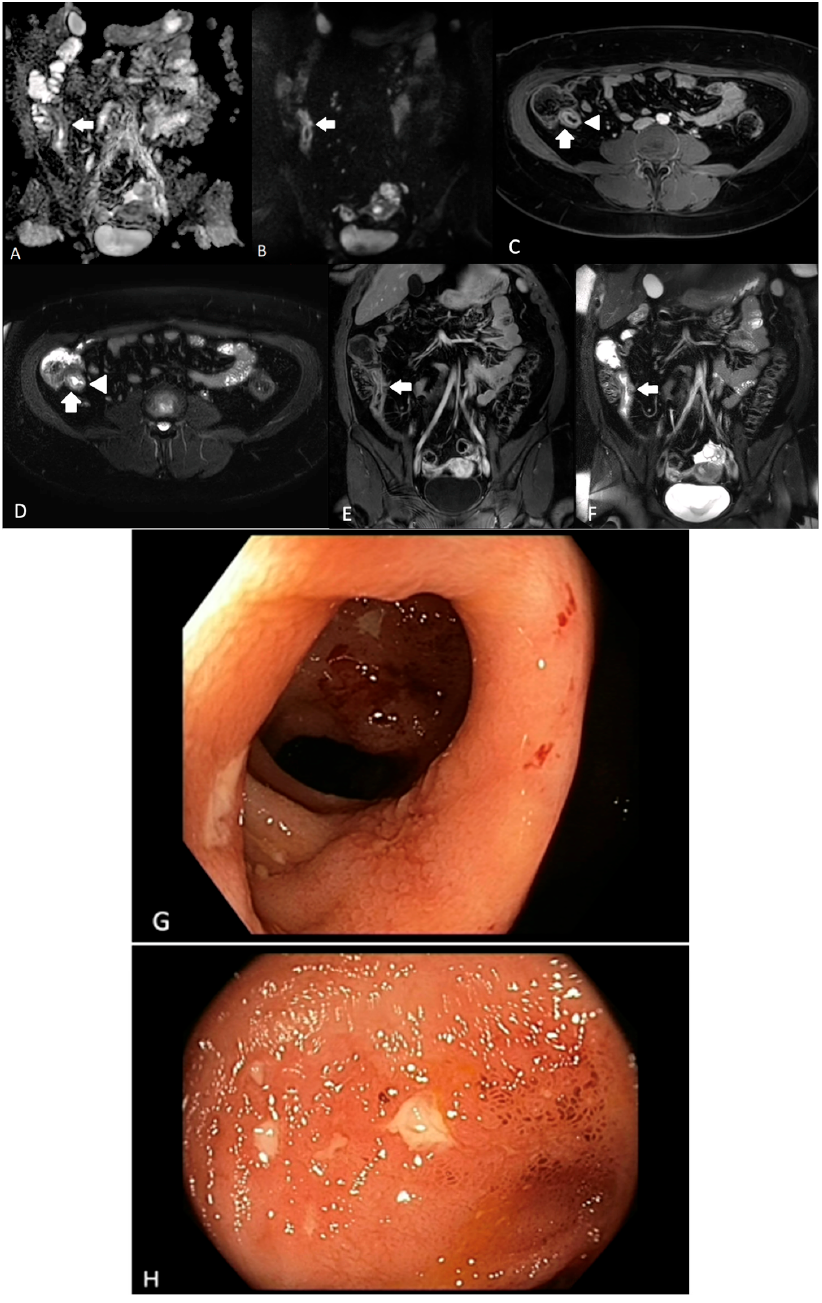
Figure 1. A 31-year-old female with known ileal CD. ( A ) ADC map and ( B ) DWI sequences demon- strating terminal ileal wall diffusion restriction indicating active inflammation (arrow); ( C ) axial T2 ‐